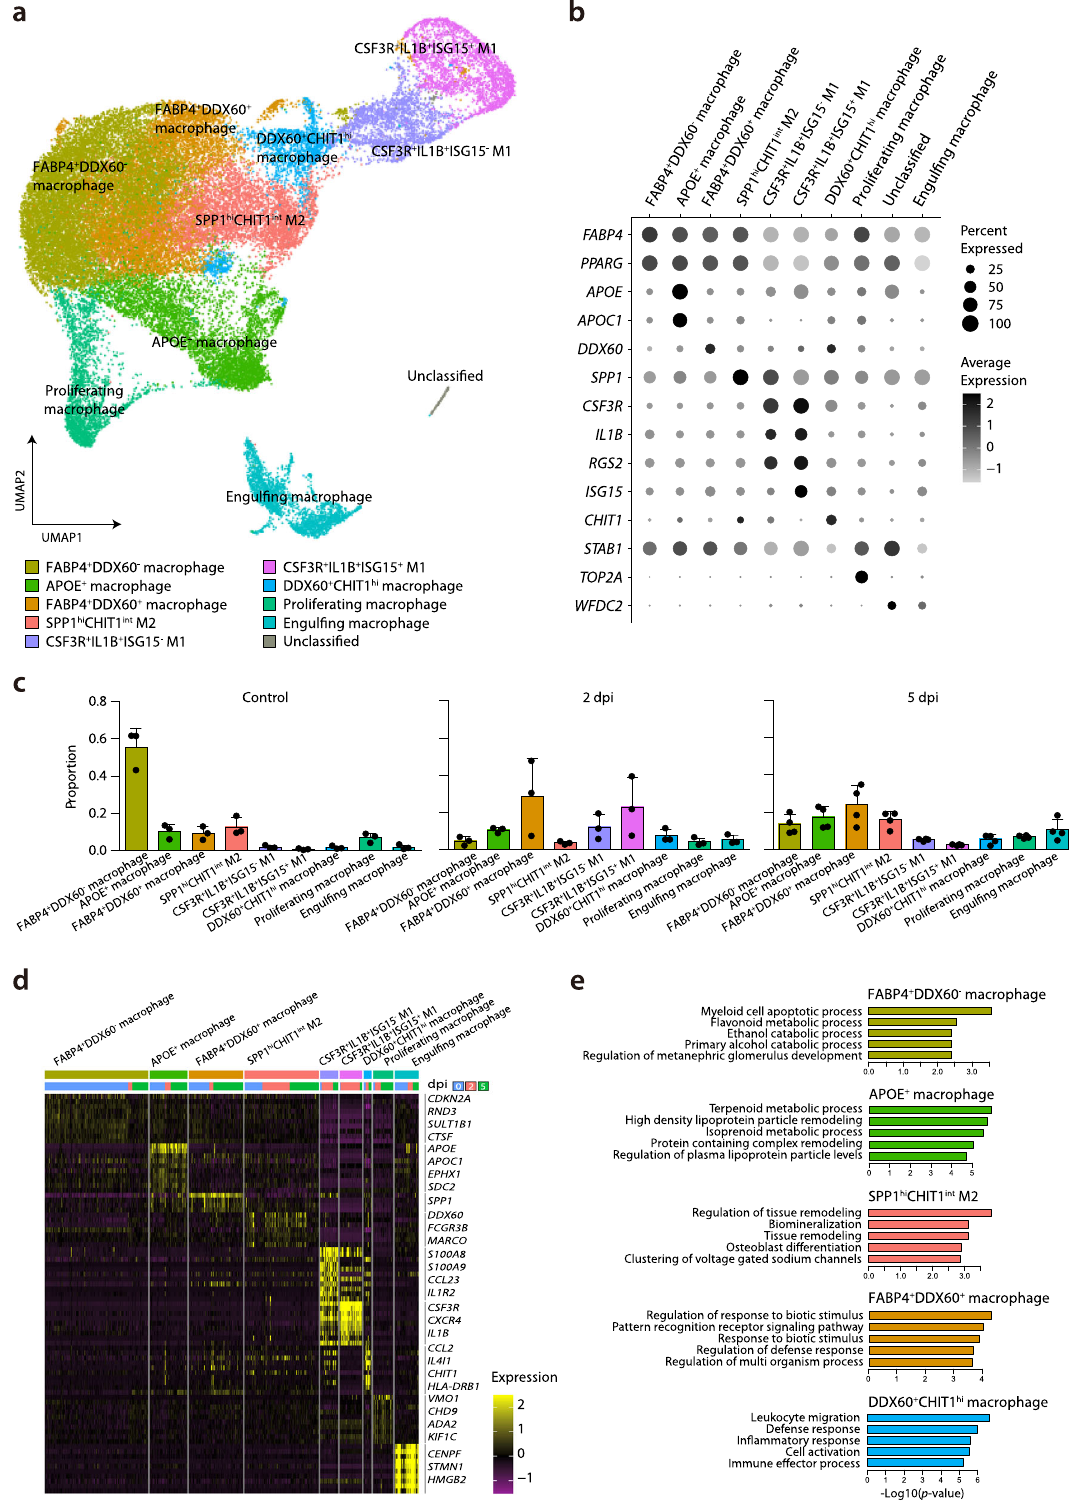
Fig. 3 Sub-clustering analysis of macrophages. a UMAP plot of the macrophage subpopulations in all groups, colored to show cluster information. b Ten different clusters and their speci fi c marker gene expression levels, with brightness indicating log-normalized average expression, and circle size indicating the percent expressed. c Proportion of each macrophage cell type at uninfected control ( n = 3), 2 dpi ( n = 3), and 5 dpi ( n = 4). The height of bars indicates mean and error bars indicate standard deviation. d Heatmap of cluster-speci fi c differentially expressed genes (DEGs), for each macrophage cell type ( n = 9). The color indicates the relative gene expression, and representative genes are shown together. e Bar plots showing − log10( p value) from enrichment analysis of representative GO biological pathways among FABP4 + DDX60 − macrophages (resting tissue macrophages), APOE + macrophages, SPP1 hi CHIT1 int M2 (potentially pro fi brogenic), FABP4 + DDX60 + macrophages (activated tissue macrophages), and DDX60 + CHIT1 hi macrophages (monocyte-derived in fi ltrating). The p values are calculated from a theoretical null distribution with a two-sided Wilcoxon signed-rank test. Source data are provided as a Source Data fi